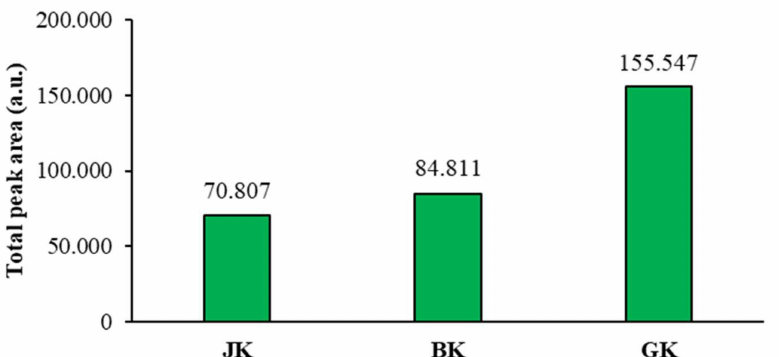
Figure 7. Comparison of the mean of the total peak areas of proanthocyanidins (blue bands in chromatograms) for STSs from leaves of Japanese ( JK ), Bohemian ( BK ), and giant ( GK ) knotweed. The mean of the total peak areas was calculated from the total peak areas of videodensitograms of two equal applications of the same STS on HPTLC silica gel plates (Figure 4) after development with developing solvent toluene-acetone-formic acid (3:6:1, v / v ) and after derivatization with